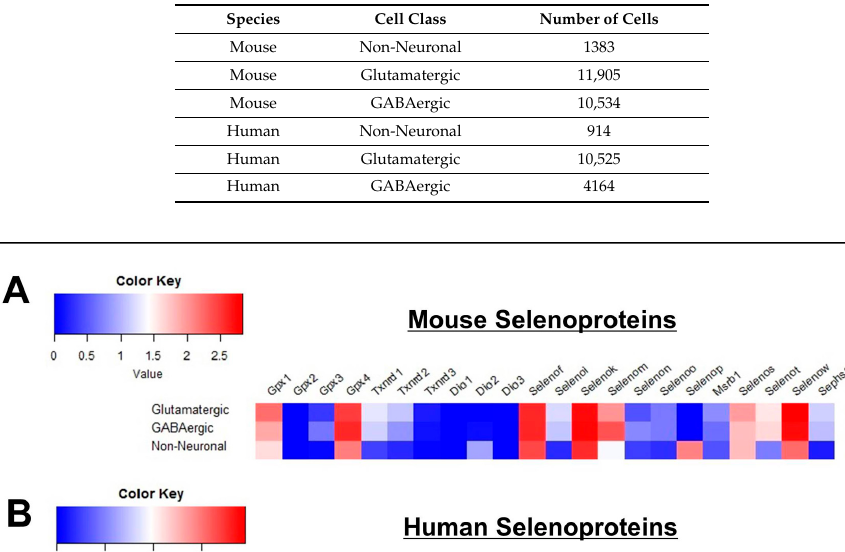
Table 1. Cells used to generate data for Figure 1.